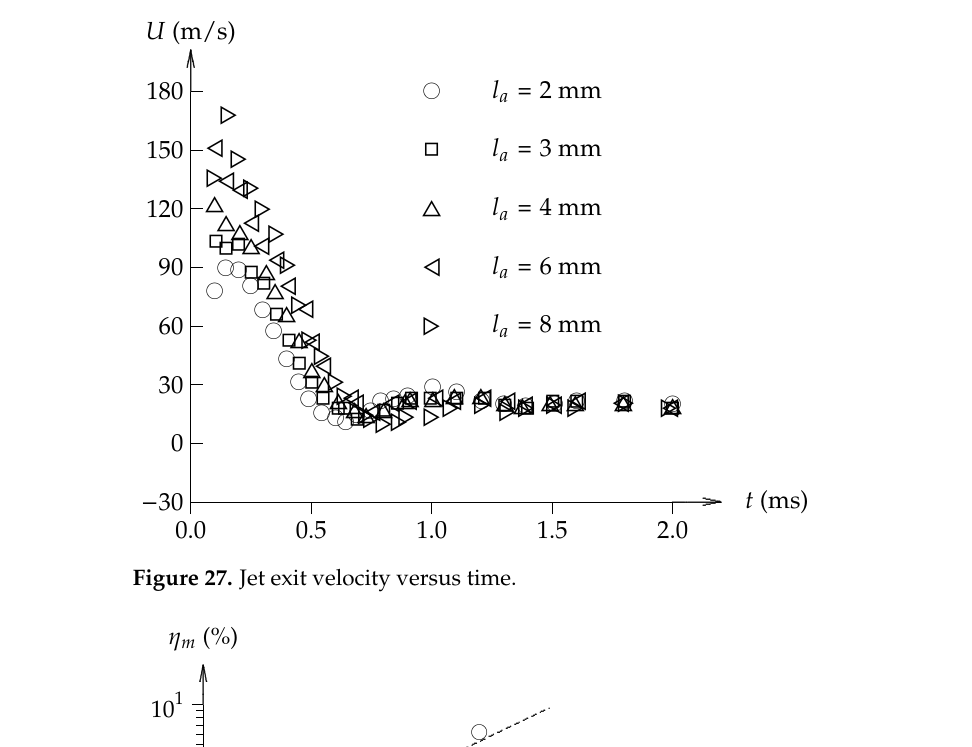
14 of 41 Figure 28. Large cavity model. Adapted from [62]. Table 7. Experiments